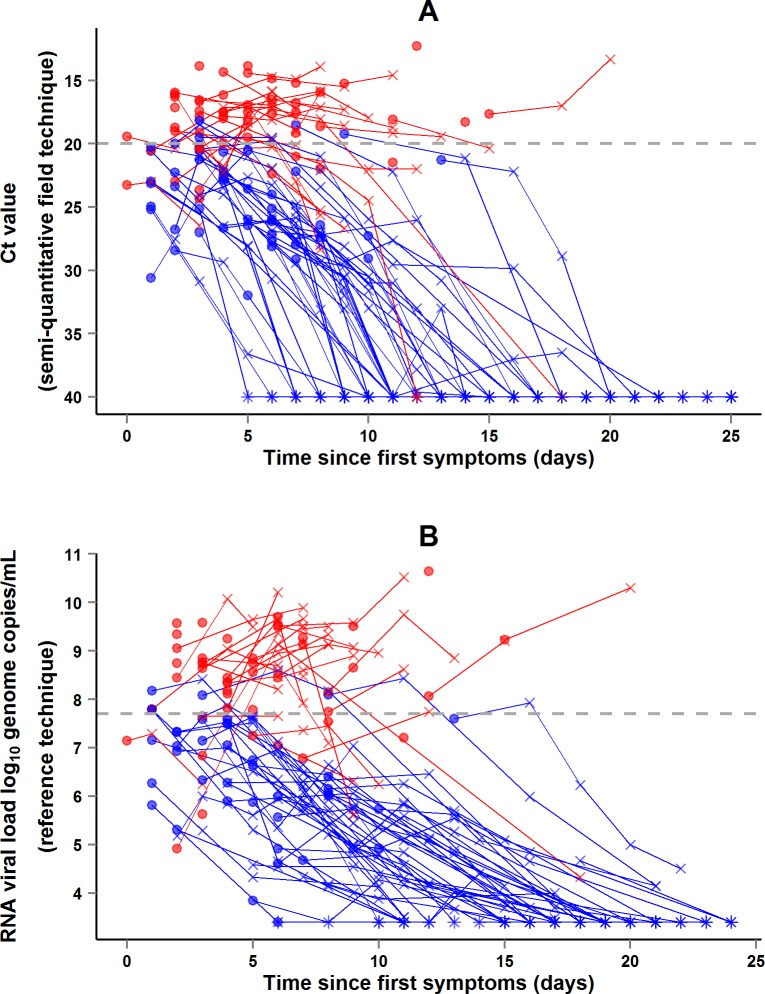
JIKI trial: evolution of RT-PCR Ct values and RNA viral load in adolescents and adults.(A) Evolution of RT-PCR Ct values. (B) Evolution of RNA viral loads. The x-axis represents the time since first symptoms (for example, for a patient whose first symptom occurred 5 d before admission to the treatment center, the baseline value dot is positioned at 5 d). Each line represents one patient. Dots represent baseline values, X’s represent follow-up values, and asterisks represent values below the limit of quantification. Red symbols represent patients who died; blue symbols represent patients who survived.